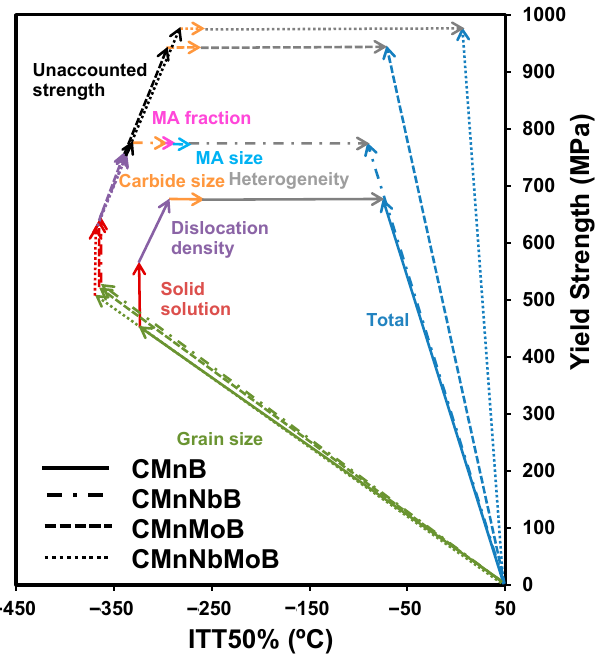
Figure 12. Relative contribution of different strengthening mechanisms (grain size, solid solution, dislocation density, unaccounted strength, presence of MA and heterogeneity) on both strength and toughness properties.